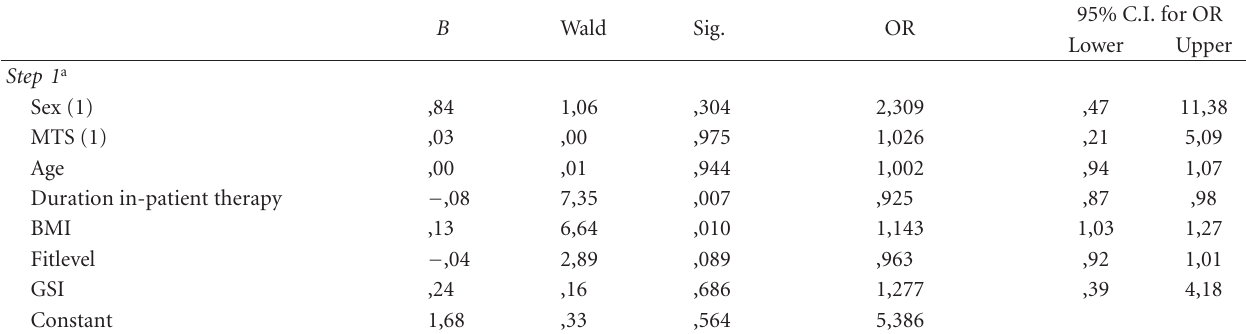
Table 7: Variables in the logistic regression model. B Wald